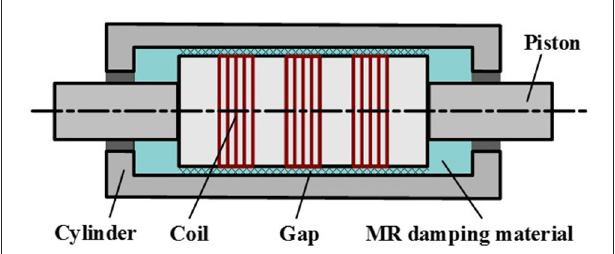
FIGURE 1 | Schematic diagram of the shear-valve type MR damper.